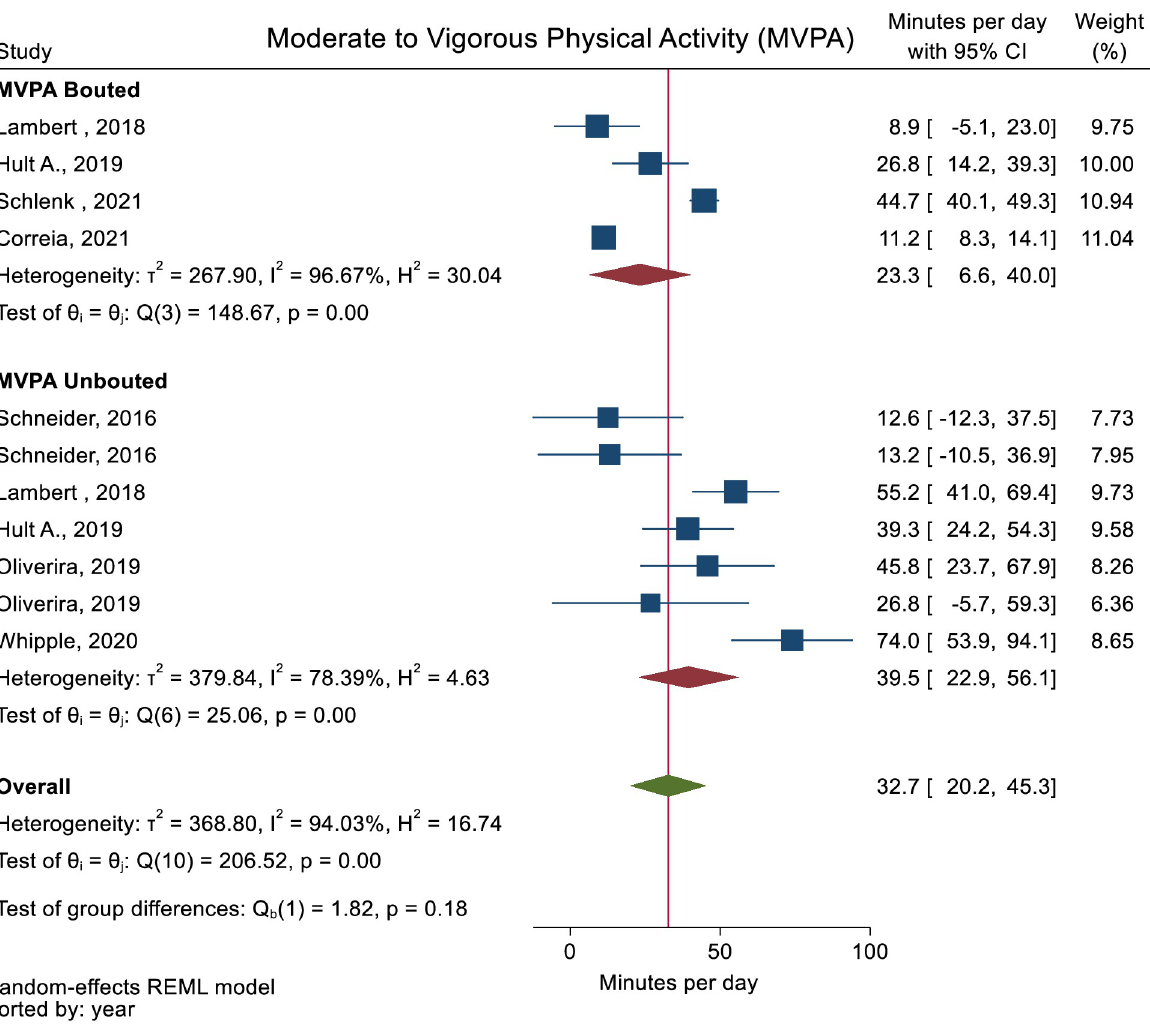
Fig 4. Forest plot showing daily minutes of Moderate to Vigorous Physical Activity (MVPA) in people with multimorbidity.